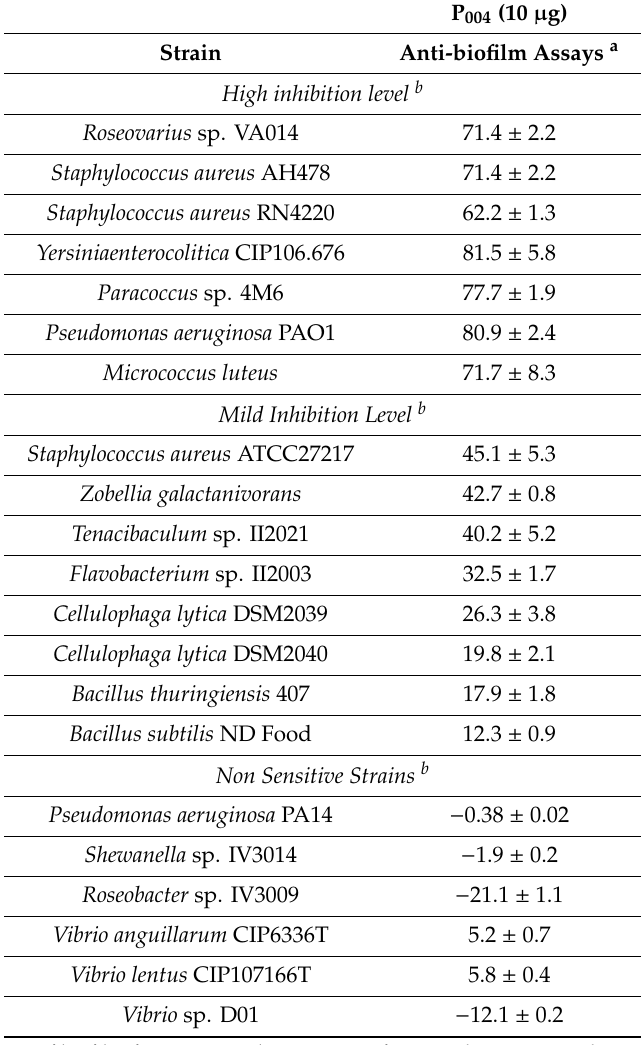
Table 2. Spectrum of action of the P 004 anti-biofilm molecule purified from SN IIIA004